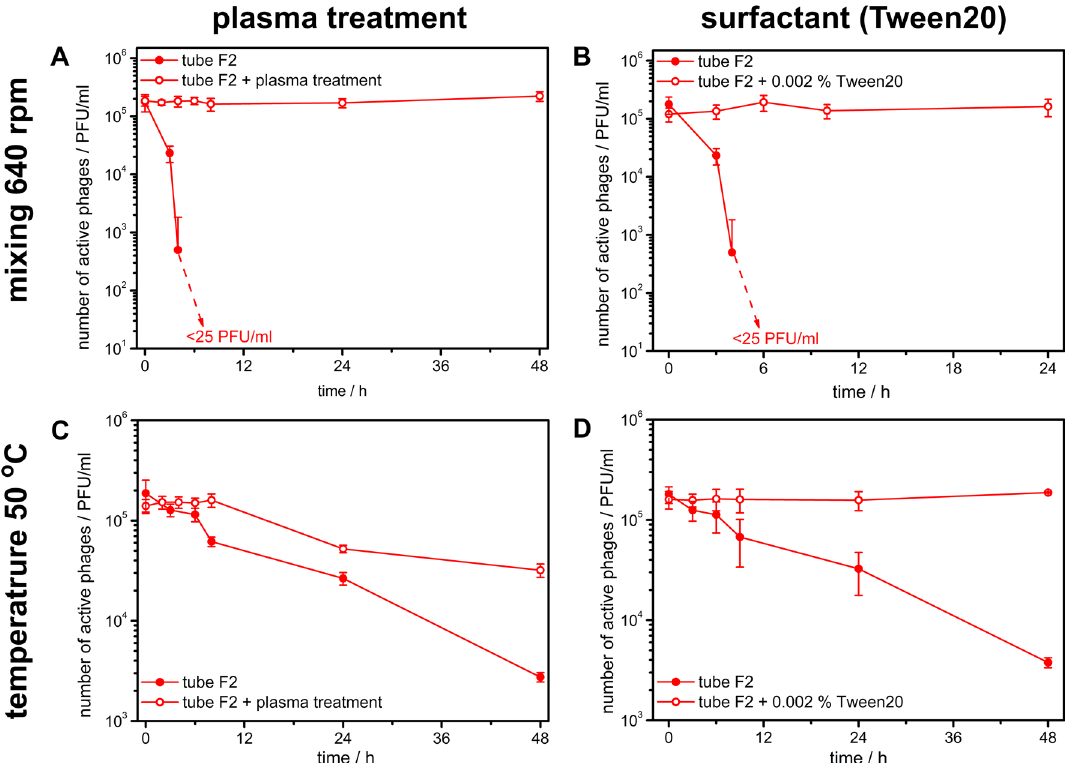
Figure 4. Influence of plasma treatment of PP tubes and addition of 0.002% v/v of Tween20 on the adsorption of phages on walls of the “unsafe” Falcon-type tubes. In each treatment, we measured changes in the number of active phages T4 in time in two sets of conditions: upon mixing and at temperature 50